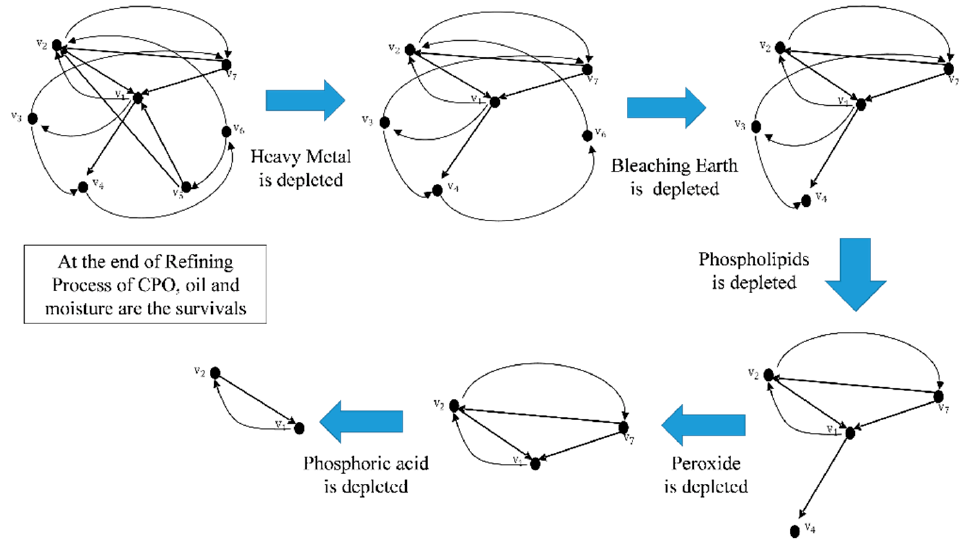
Figure 9. The dynamic of physical refining process of palm oil